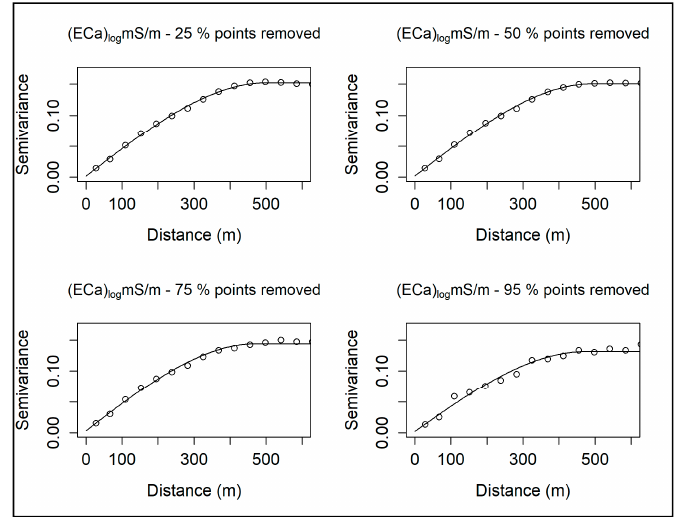
Figure 8. Empirical (circles) and adjusted (lines) semivariogram models for natural logarithm transformations of different soil ECa sample density reductions (i.e., 25%, 50%, 75%, and 95%), based on random point selection.